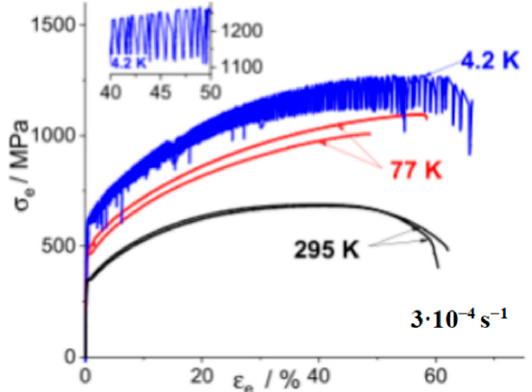
Figure 2. Mechanical response of CoCrFeMnNi under tensile load at 295, 77 and 4.2 K. Reprinted with permission from Ref. [20]. Copyright 2018, Springer Nature.